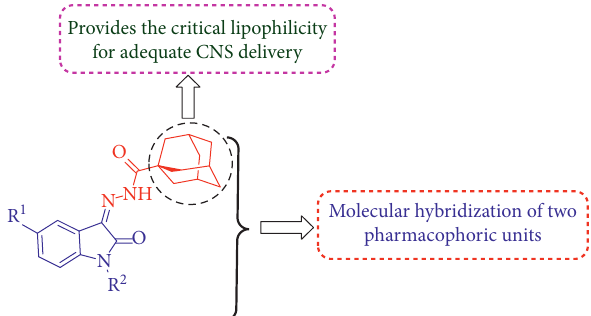
Figure 3: General chemical structure of the hybrid